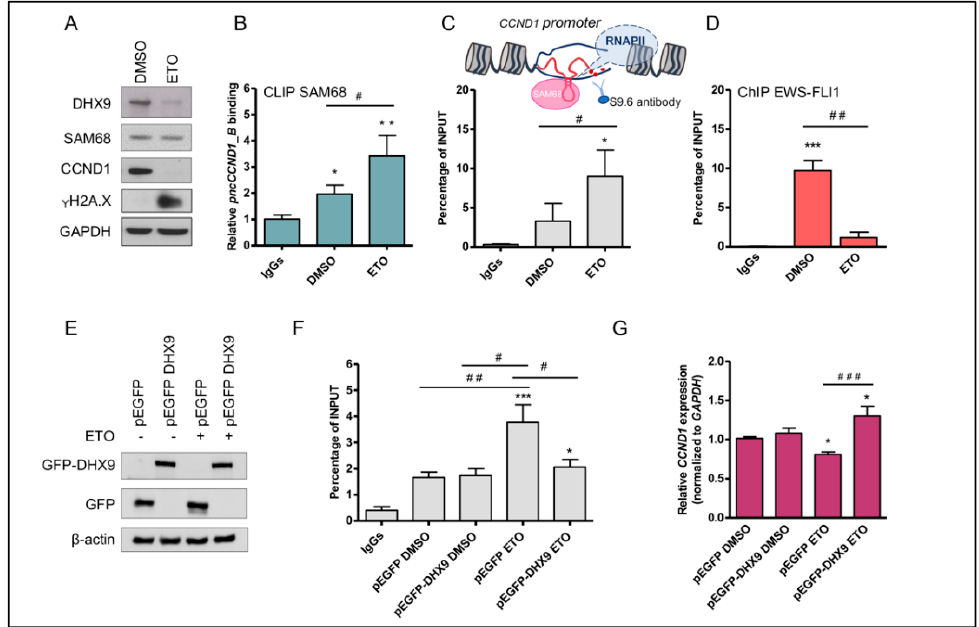
Figure 3. Etoposide induces the formation of DNA:RNA hybrids at CCND1 promoter. ( A ) Western blot analyses were performed on 15 µg of total extracts of TC-71 cells treated for 16 h with either DMSO (vehicle) or 5 µM etoposide (ETO). DHX9, Sam68, CCND1, and γ H2A. X protein levels were analyzed. GAPDH was used as loading control. ( B ) Histograms represent Sam68 binding to pncCCND1_B from cross-linked and immunoprecipitation experiments. Values are expressed as in- put percentage and normalized to IgGs signal. ( C ) qPCR analysis of S9.6 immunoprecipitated chro- matin from DNA:RNA heteroduplex in the promoter region of the CCND1 gene. As represented in the illustration, the S9.6 antibody recognizes DNA:RNA hybrids. ( D ) EWS-FLI1 recruitment on the CCND1 promoter was evaluated by ChIP experiments. Histograms represent input percentage from three independent experiments. Statistical analysis was performed by ANOVA with Bonferroni cor- rection p -value (*, # <0.05, **, ## <0.01, ***, ### <0.005). ( E ) Western blot analysis to monitor recombinant expression of GFP or GFPDHX9 in TC-71 cells, treated with either DMSO or etoposide 5 µM. Ten µg of total extract was loaded in each lane. ( F ) qPCR analysis of S9.6 immunoprecipitated chromatin from DNA:RNA heteroduplexes in the promoter region of the CCND1 gene. Histograms represent input percentage. Statistical analysis was performed by ANOVA with Bonferroni post hoc test. p - value (*, # <0.05, ## <0.01, *** <0.005). ( G ) RT-qPCR analysis of CCND1 expression in TC-71 cells trans- fected with either GFP or GFP-DHX9, and treated with DMSO or etoposide. Histograms represent three independent experiments (± S.D.). Statistical analysis was performed by Bonferroni corrected ANOVA. p -value (* <0.05, *** <0.005).